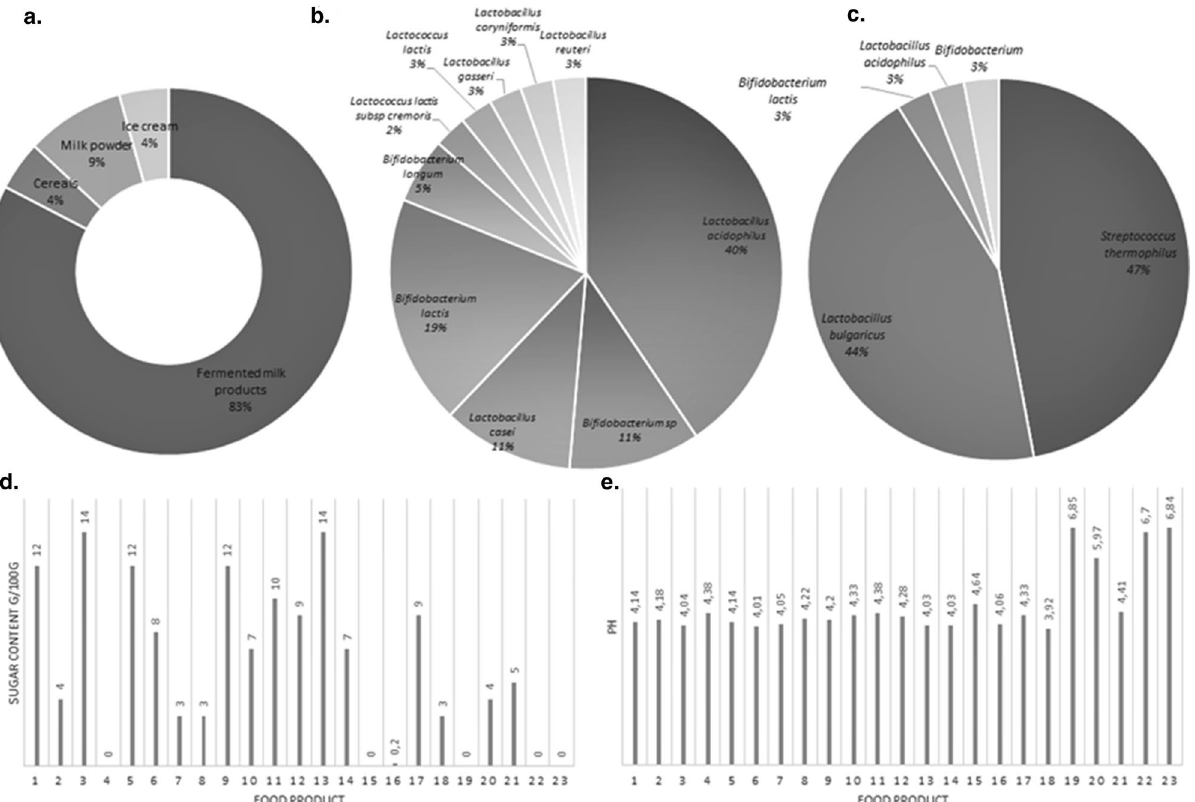
Figure 1. Characteristics of the foods with added probiotics in chain supermarkets in Colombia. ( a ) Type of food. ( b ) Probiotic bacteria announced on food label. ( c ) Fermentative bacteria announced on food label. ( d ) Sugar content announced on food label. ( e ) Initial pH of